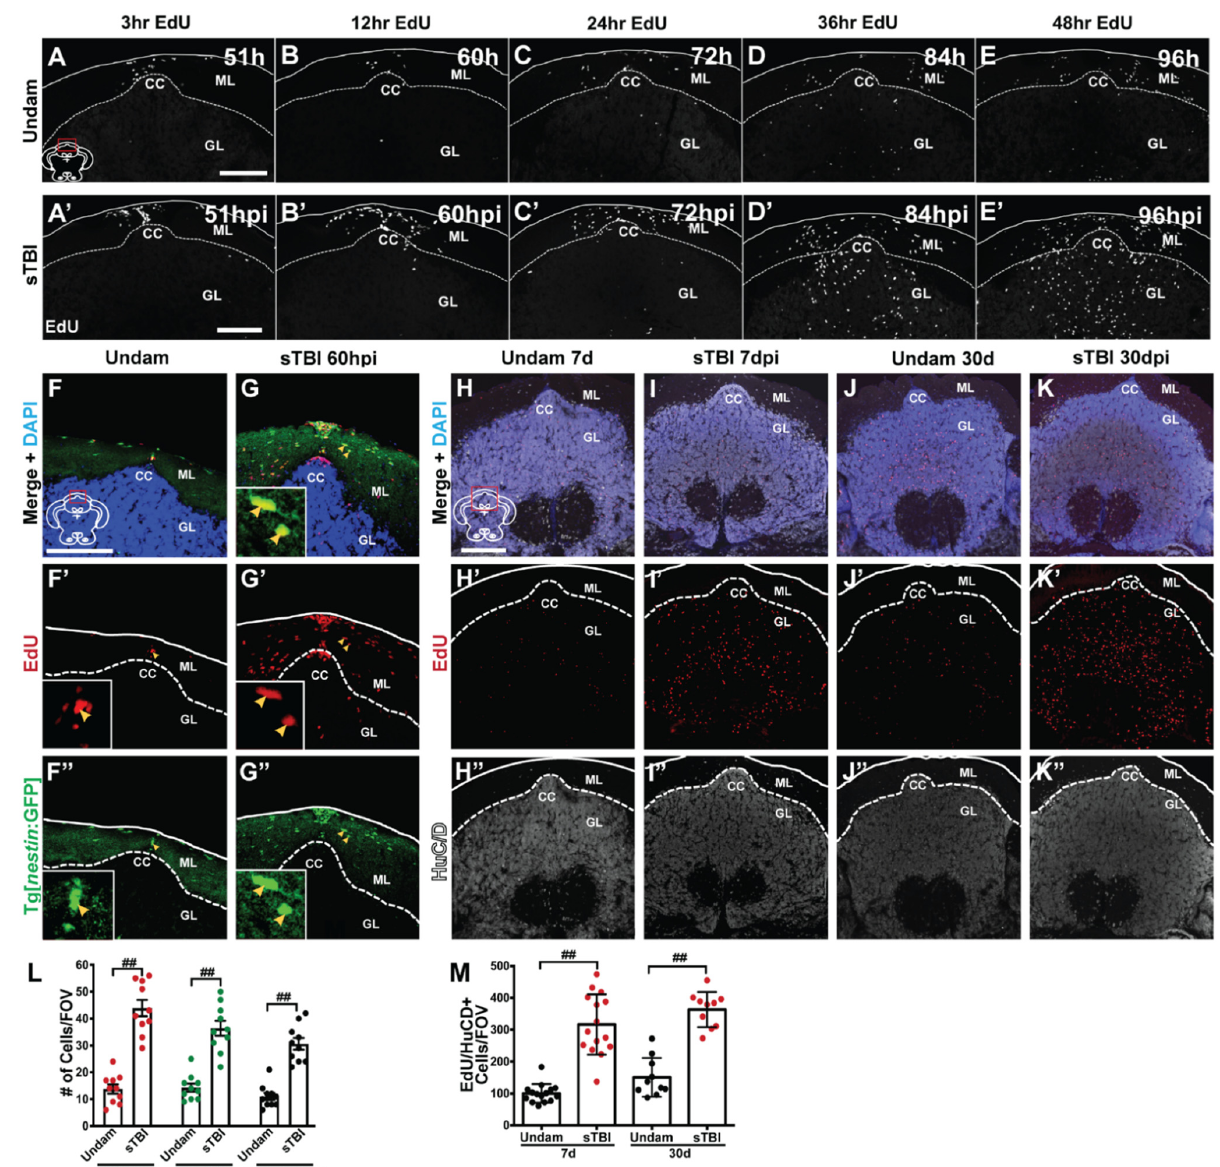
Figure 10. Blunt-force TBI induces cell proliferation, migration, and differentiation in the cerebellum. ( A – E’ ) Coronal cerebellar sections of sTBI fish ( A’ – E’ ) that were IP-injected with EdU at 48 hpi and collected 51, 60, 72, 84, and 96 hpi to identify the migration pattern of injury-induced proliferative cells. Control undamaged fish ( A – E ) were also injected and brains assessed at similar intervals as sTBI fish. Coronal cerebellar sections of undamaged ( F ) and sTBI ( G ) Tg[ nestin :GFP] fish with high magnification insets ( F’–F” , G’–G” ) that were IP-injected with EdU 12 h prior to collection at 60 hpi with colabeling of EdU and Tg[ nestin :GFP] (yellow arrowheads). Coronal cerebellar sections of undamaged ( H – H” , J – J” ) and sTBI fish ( I – I’’ , K – K’’ ) that were IP-injected with EdU at 48 and 60 hpi to capture early onset and peak proliferative events and collected at either 7 ( H – I’’ ) or 30 dpi ( J – K’’ ) and costained with HuCD. ( L ) Quantification of the number of EdU-positive, nestin :GFP-positive, or colabeled cells for experiments in representative images F – G” (n = 10). ( M ) Quantification of the number of EdU/HuCD colabeled cells for experiments in representative images H – K” (n = 15). Solid lines in A – K” denote tissue boundary, while dotted lines denote internal anatomical boundaries. Cerebellar crest, CC, granule cell layer, GL, molecular layer, ML. All scale bars = 100 µm. Mean ± SEM is depicted in L and M. Statistical analyses were performed with either a One-way ANOVA or Two-way ANOVA followed by a Tukey’s post-hoc test. ## p < 0.01. We next asked if these EdU-positive cells that infiltrated the granule cell layer differ- entiated into neurons. Undamaged and sTBI fish were given EdU pulses at 48 and 60 hpi